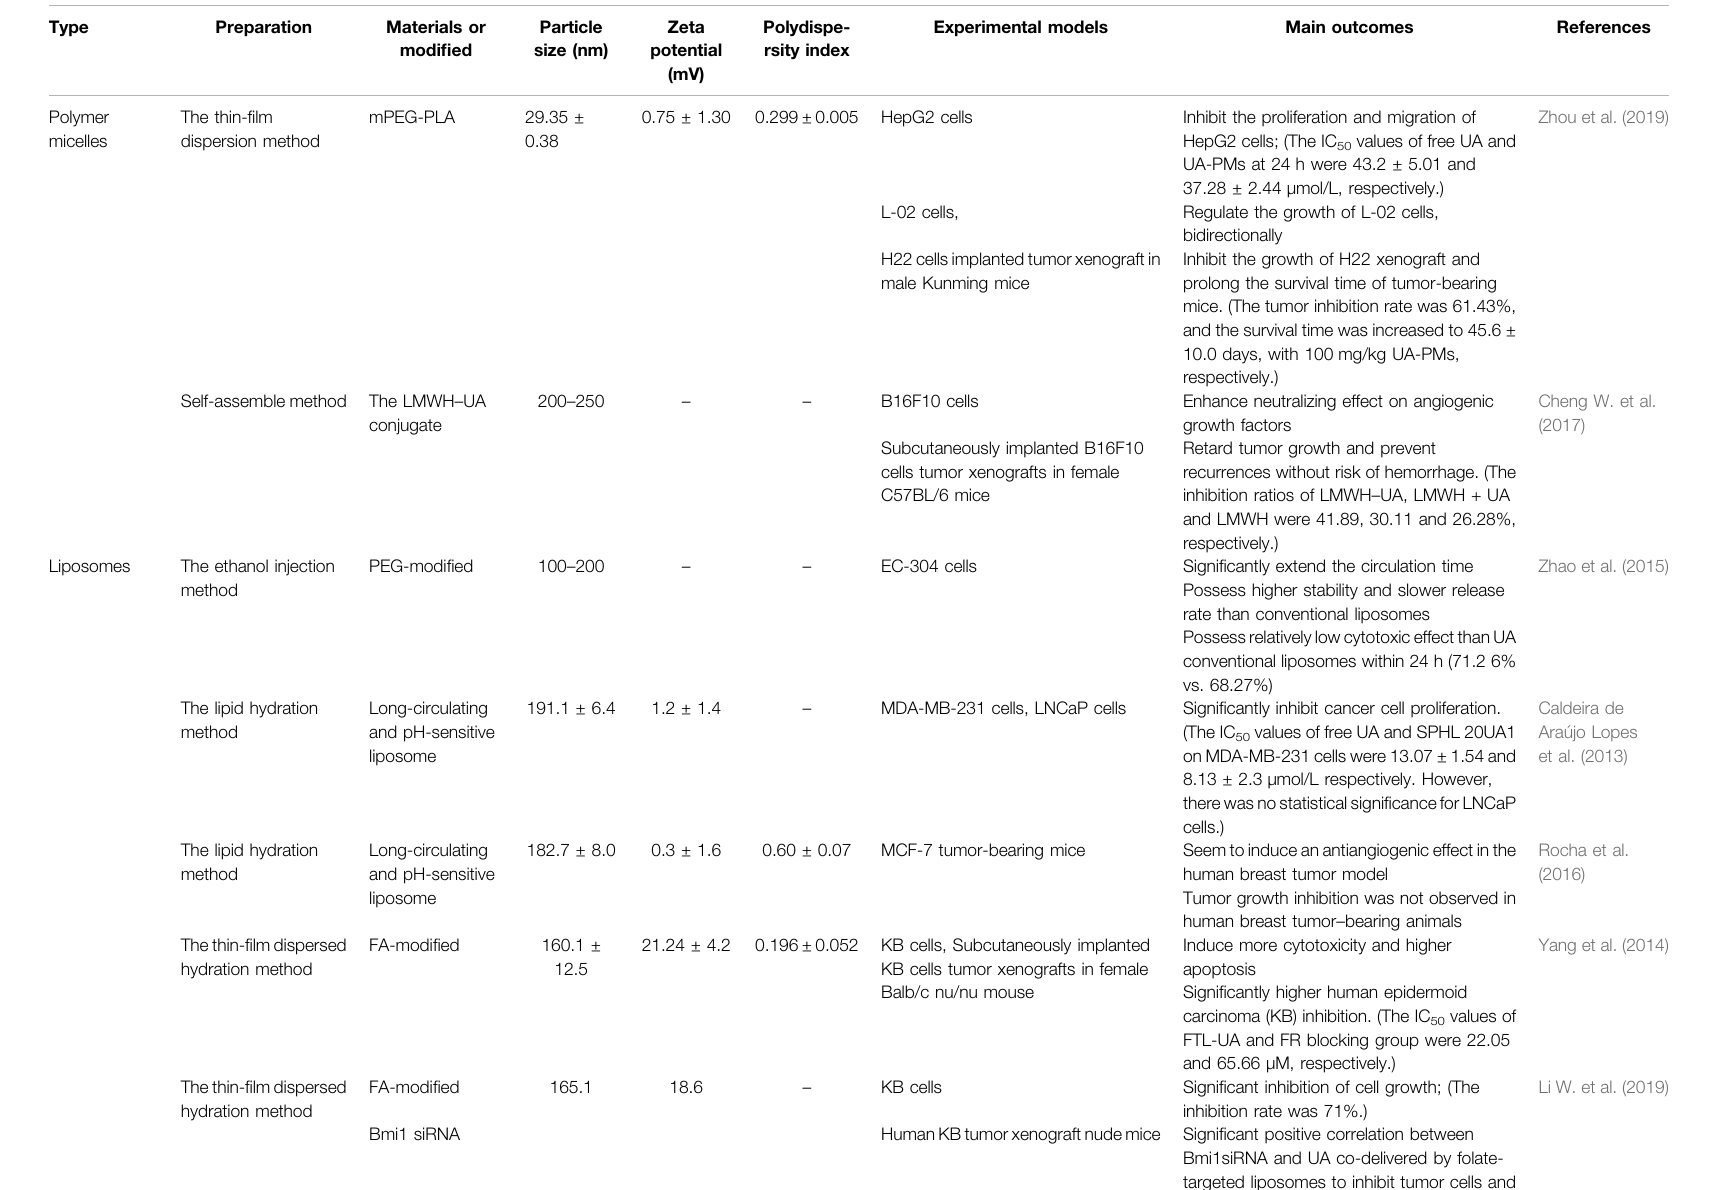
TABLE 2 | The preparation, characteristics, and results about the anti-cancer effects of UA